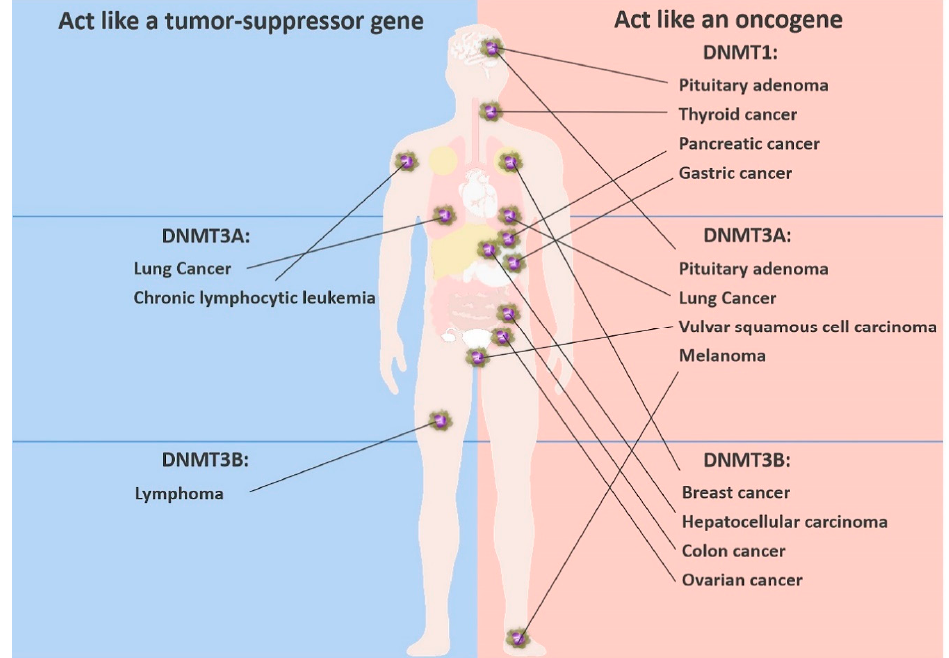
Figure 2. The DNMT paradox and the different roles of DNMTs in various cancers in mammals. DNMT3A can act both as an oncogene and as a tumor suppressor gene in lung cancer. Other DNMTs play different roles in other cancers.